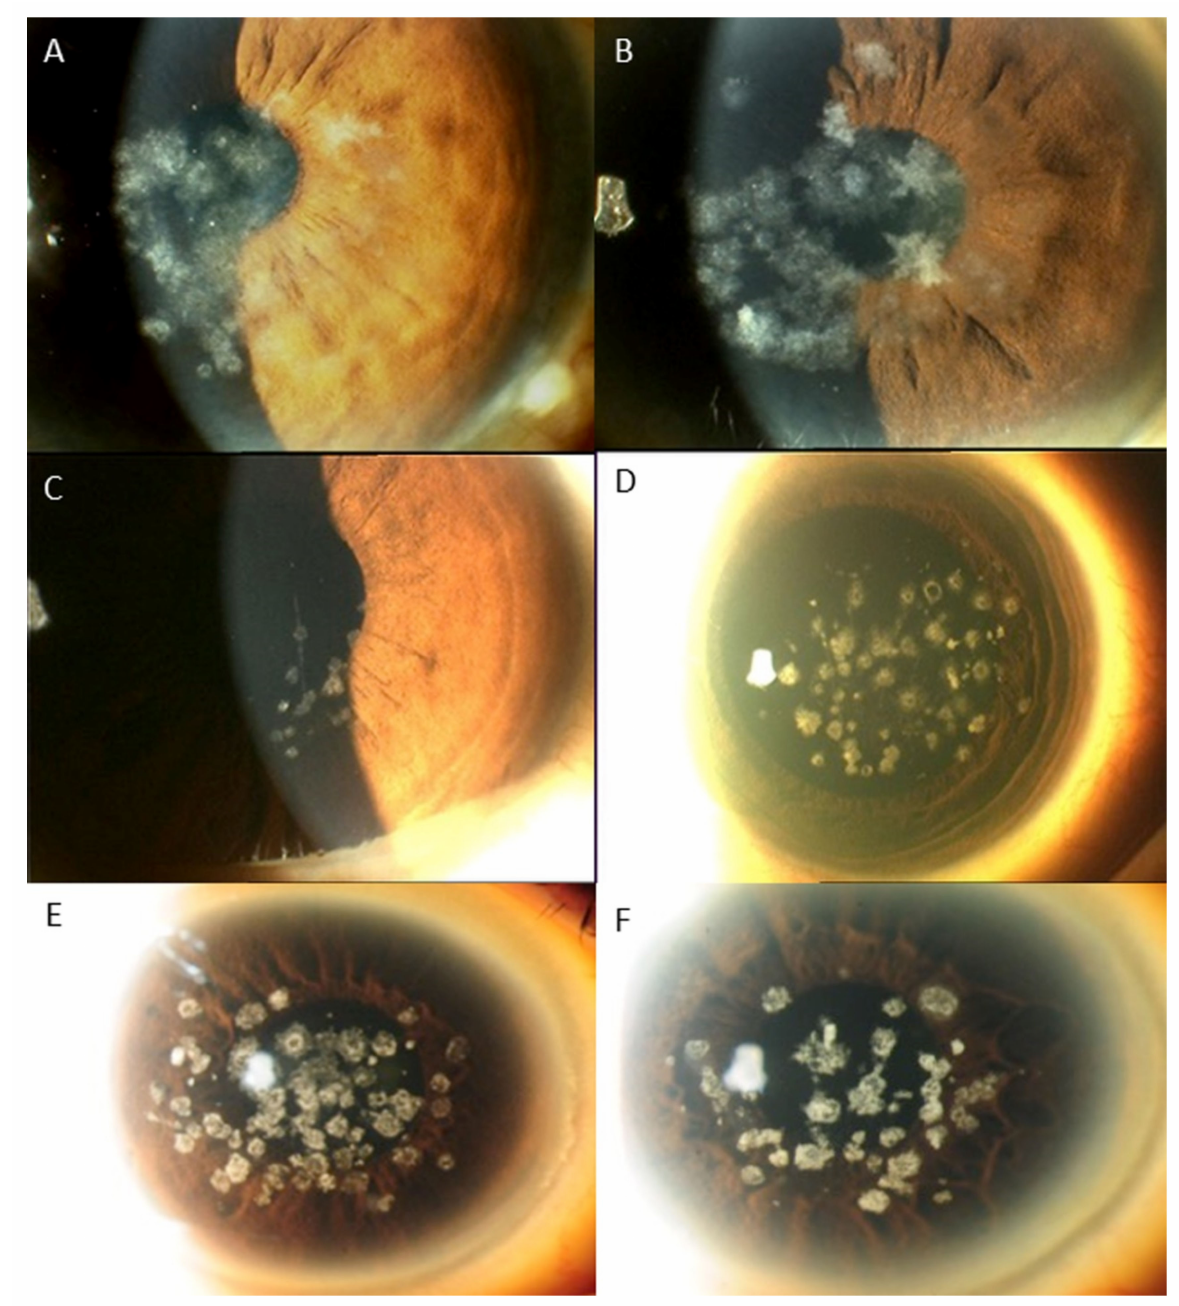
Figure 1. The phenotypic variations associated with mutation at R124H: ( A ): Classic bread crumb like whitish lesions in the anterior stroma that can be seen GCD1; ( B ): Similar to A but a few lesions have stellate pattern that is seen in GCD2; ( C ): Few translucent dots that can be seen in GCD1; ( D ): multiple grayish white dots, some with moth eaten central clearing and some spiky deposits that can be seen in GCD 2; ( E ): classic bread crumb like lesions with clear intervening stroma that can be seen in GCD1; ( F ): similar bread crumb like lesions interspersed with some spiky deposits that can be seen in